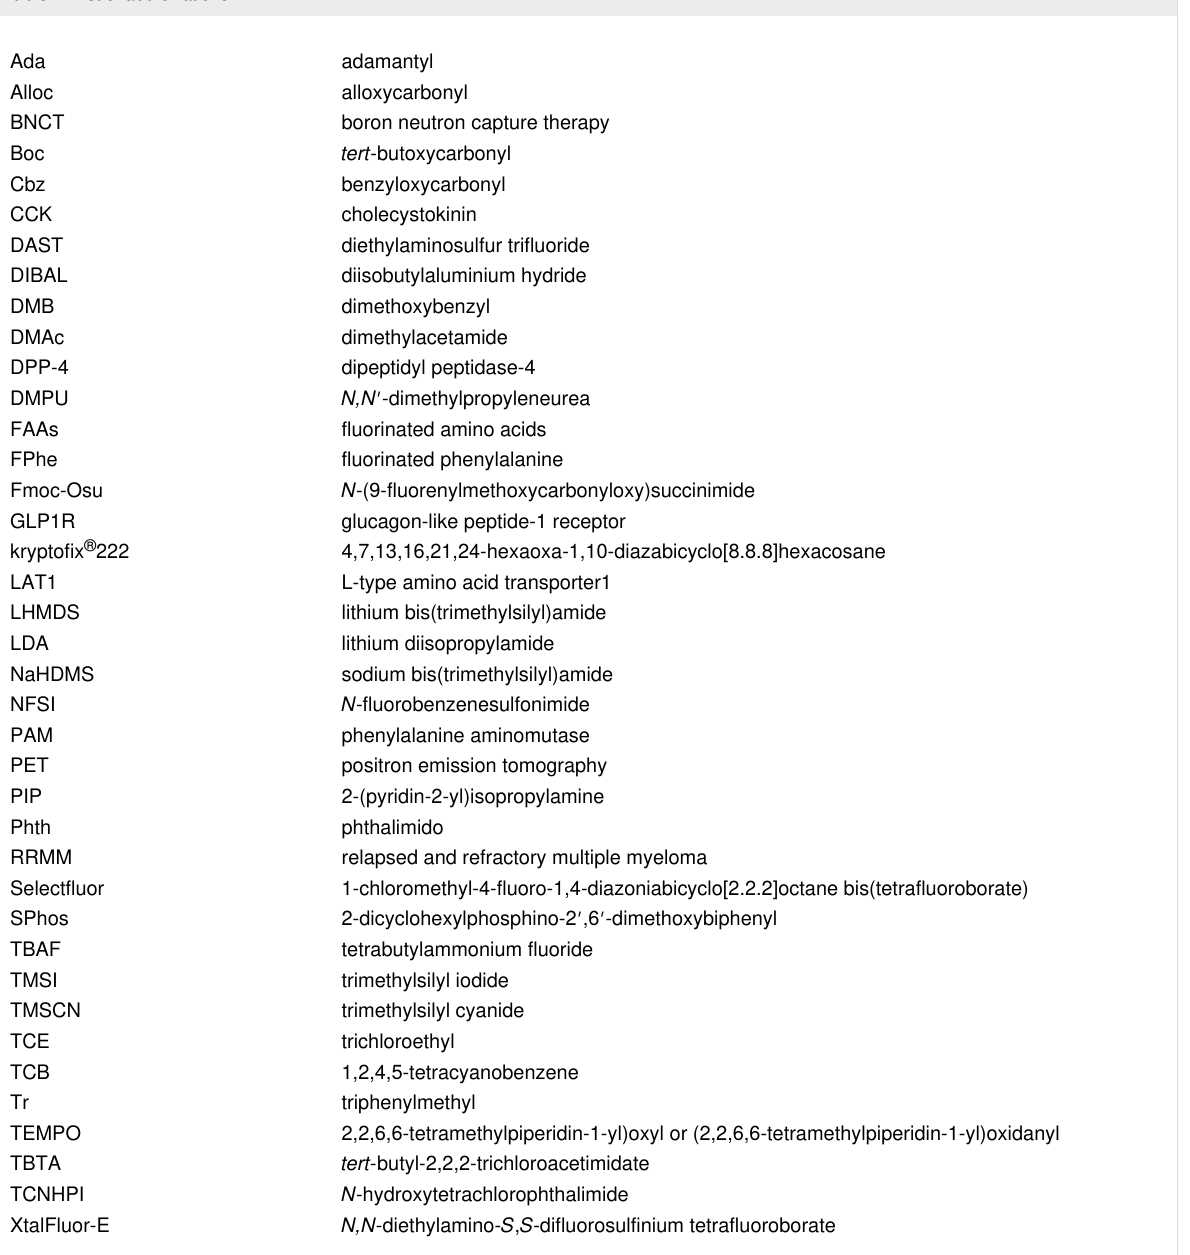
Table 1: List of